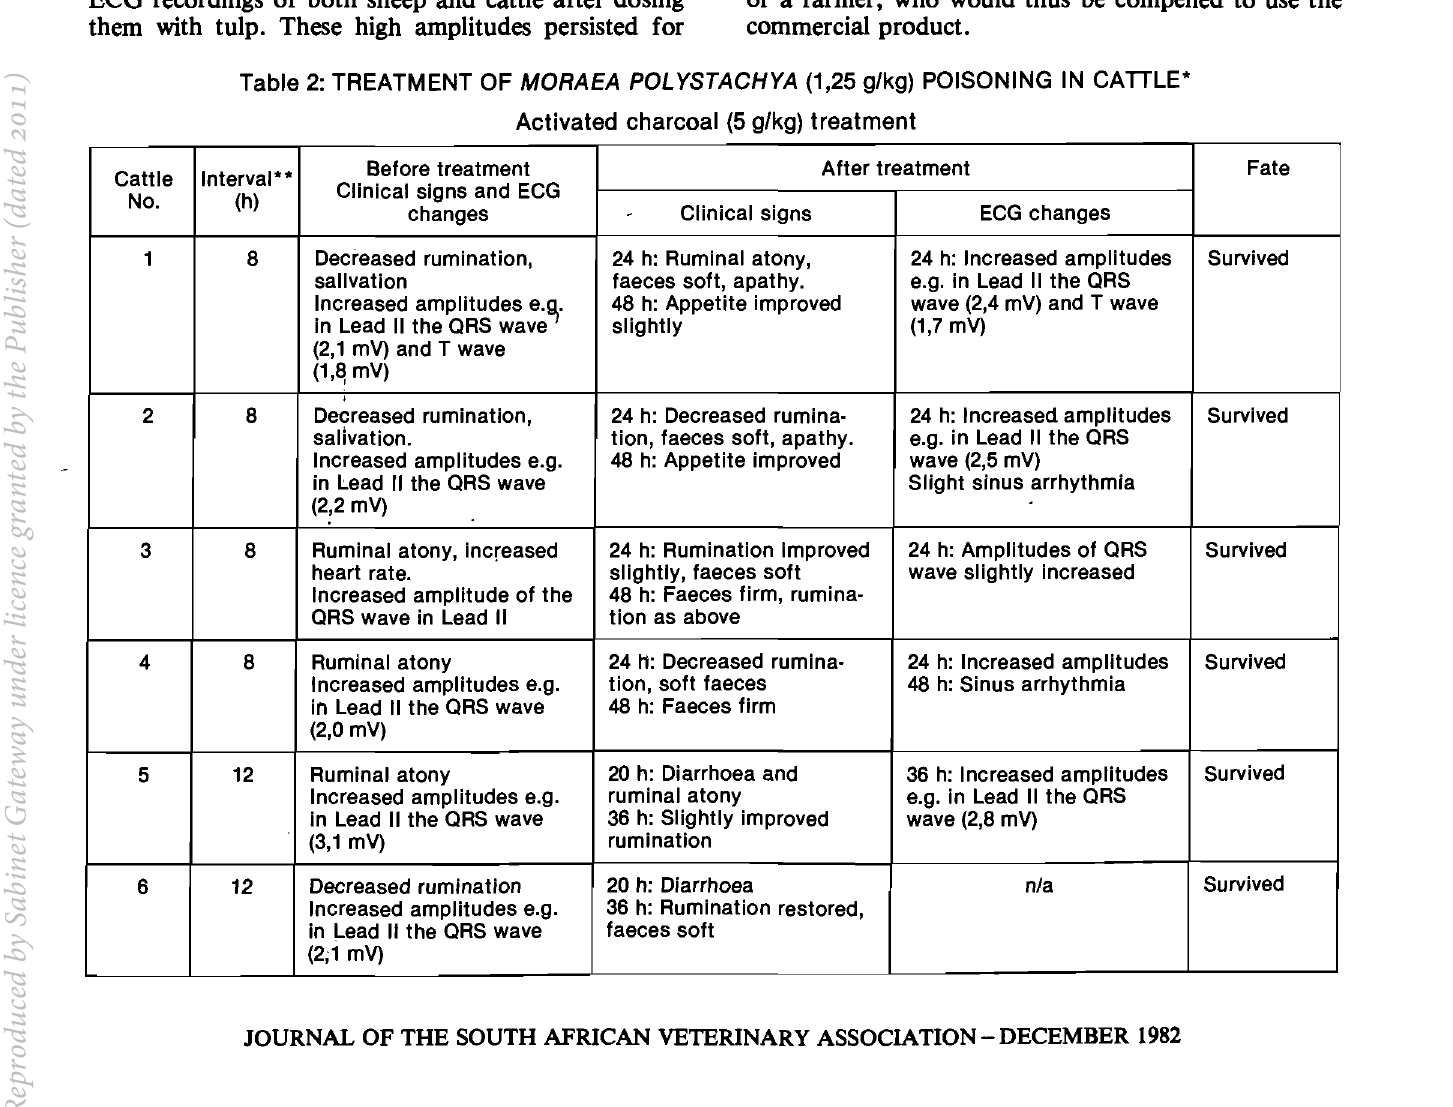
Table 2: TREATMENT OF MORAEA POLYSTACHYA (1,25 g/kg) POISONING IN CADLE· Activated charcoal (5 g/kg)